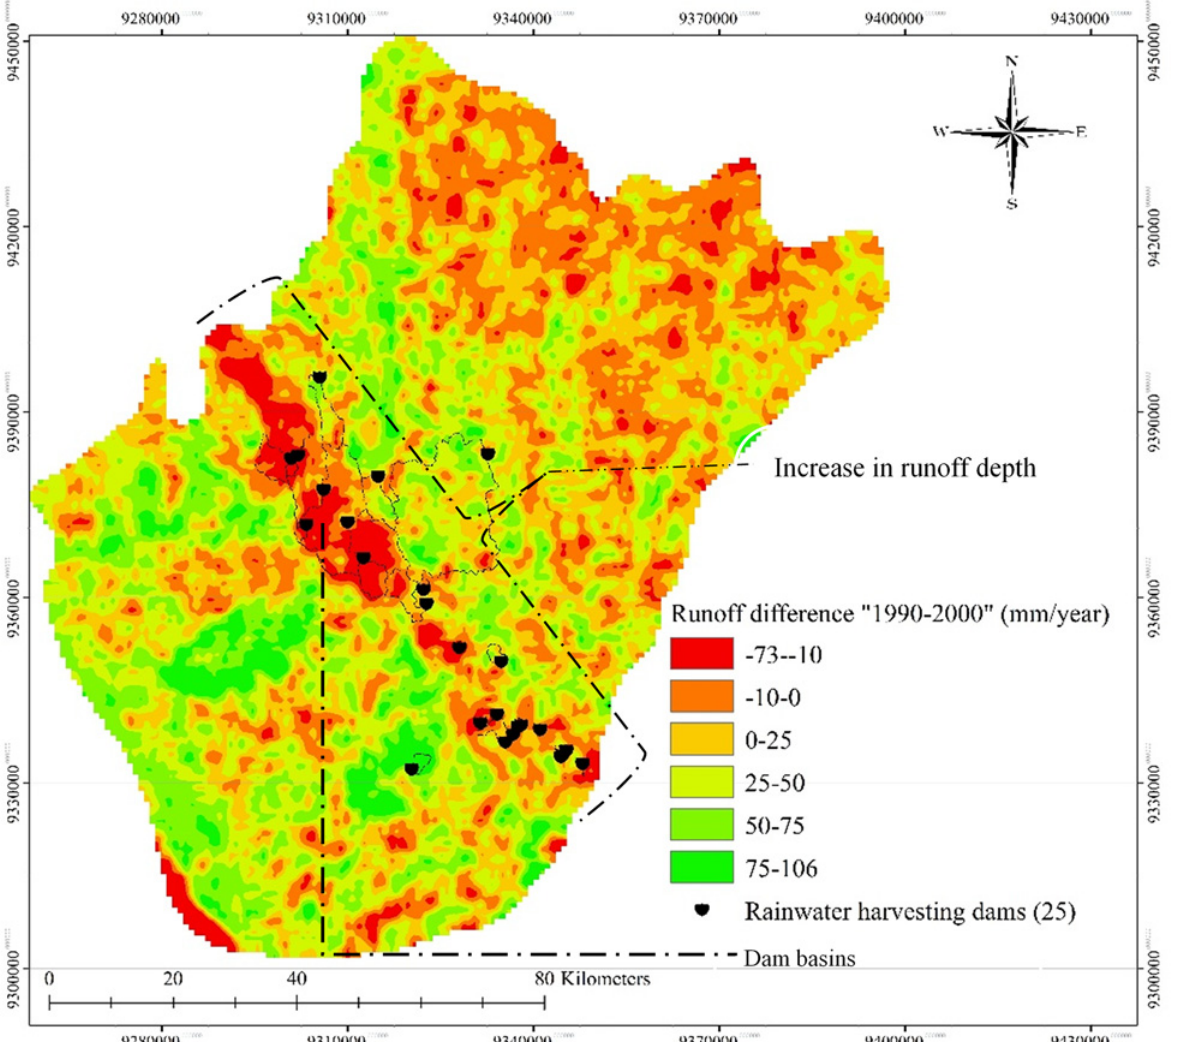
Fig 6. Average change in land cover between 1990 and 2000 in the study